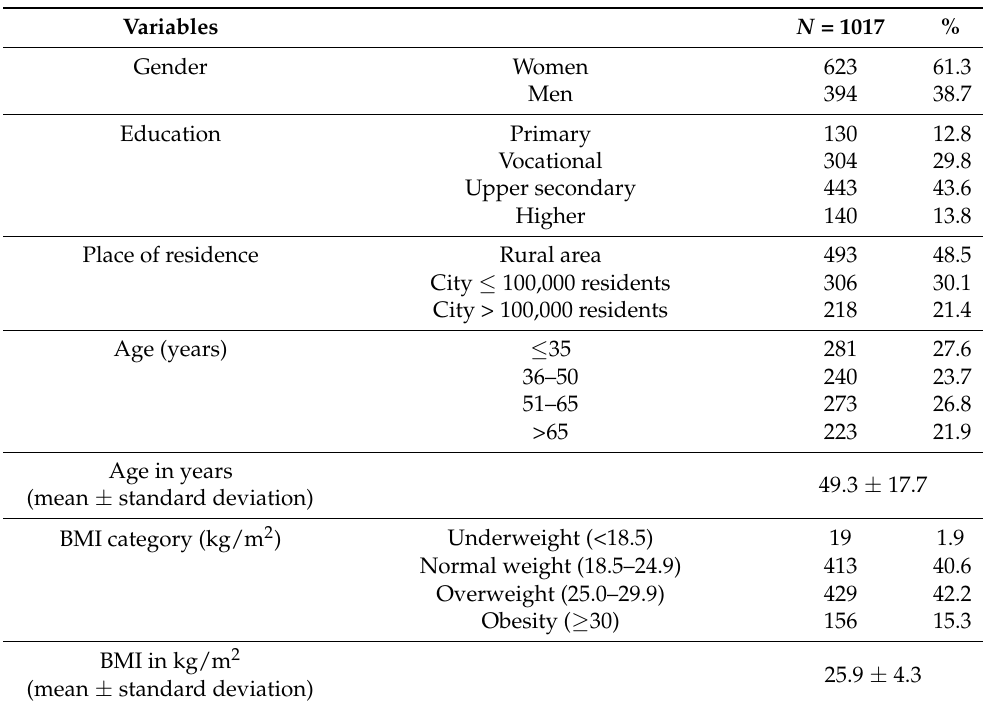
Table 2. Study sample